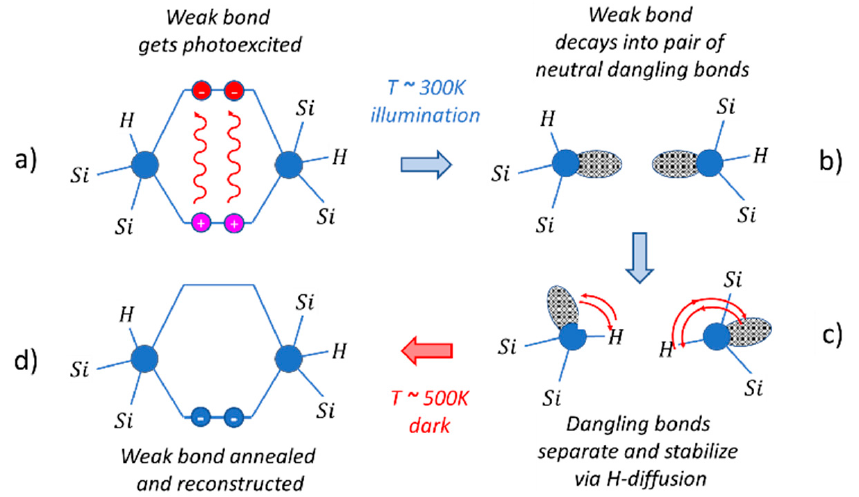
Figure A5. ( a ) Photo-dissociation of weak bonds (Staebler–Wronski effect [57]) into pairs of neutral dangling bonds ( b ) which separate via H-diffusion ( c ). Separated dangling bonds are metastable at room temperature ( c ). In darkness, weak bonds can reform at elevated temperatures and under conditions of enhanced H-mobility ( d ).